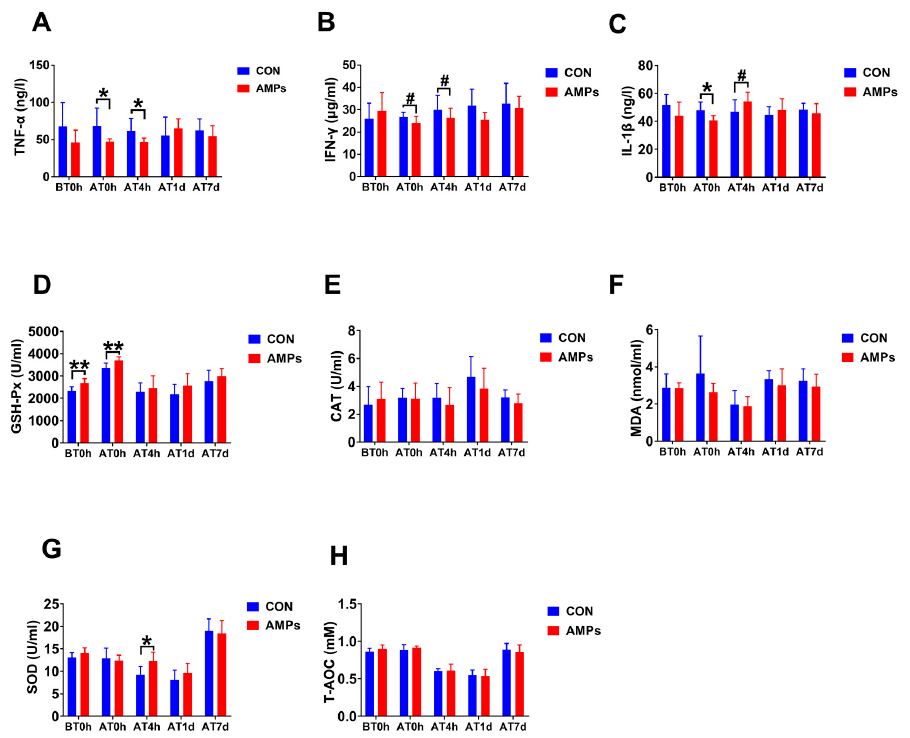
Figure 3. Effect of AMPs on inflammatory factors ( A – C ) and antioxidant capacity ( D – H ) in ragdolls. Symbol (*) indicates statistically significant differences between two groups (* p < 0.05 and ** p < 0.01), and symbol (#) indicates difference tendencies (0.05 < # p < 0.10) between two groups. BT0h, right before transportation; AT0h, right after transportation; AT4h, 4 h after transportation; AT1d, 1 day after transportation; AT7d, 7 days after transportation.